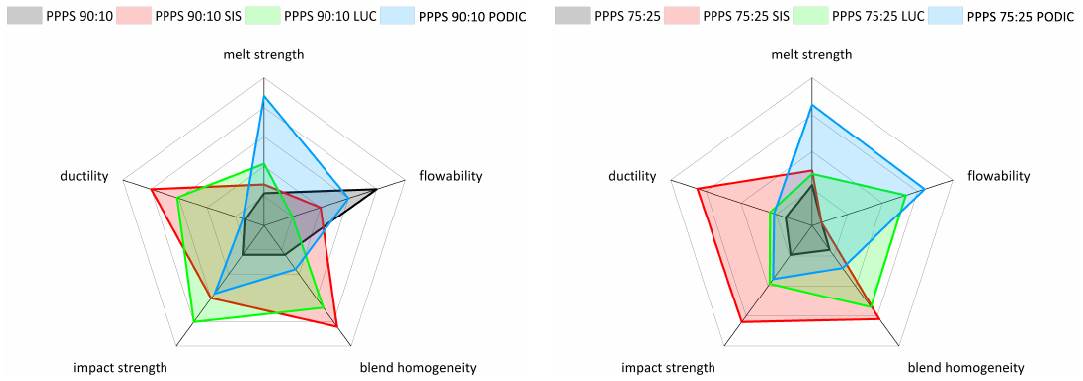
Figure 14. Overall blend performance of the different PP–PS blend compositions related to material testing